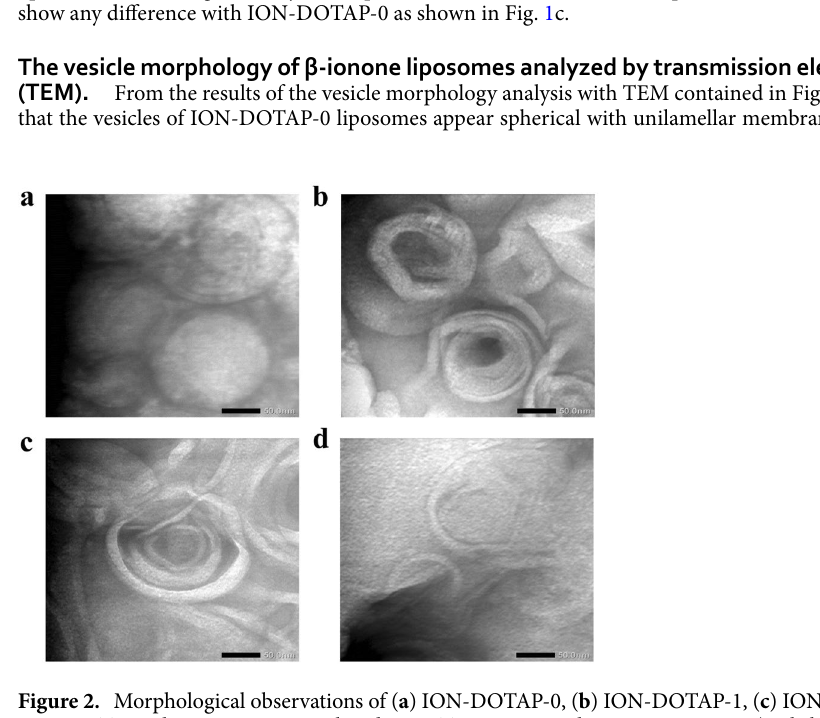
Figure 2. Morphological observations of ( a ) ION-DOTAP-0, ( b ) ION-DOTAP-1, ( c ) ION DOTAP-2, and ( d ) ION-DOTAP-3 liposomes were analyzed using Transmission Electron Microscopy (scale bar: 50